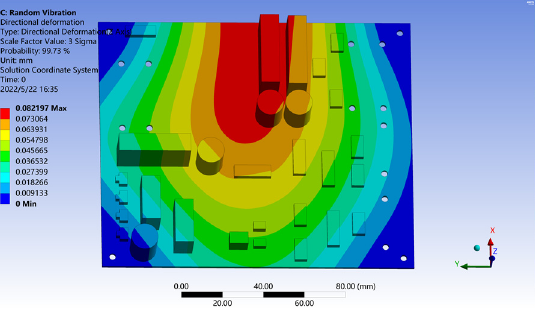
Figure 12. Deformation results of the PCB under random roadside vibration excitation.